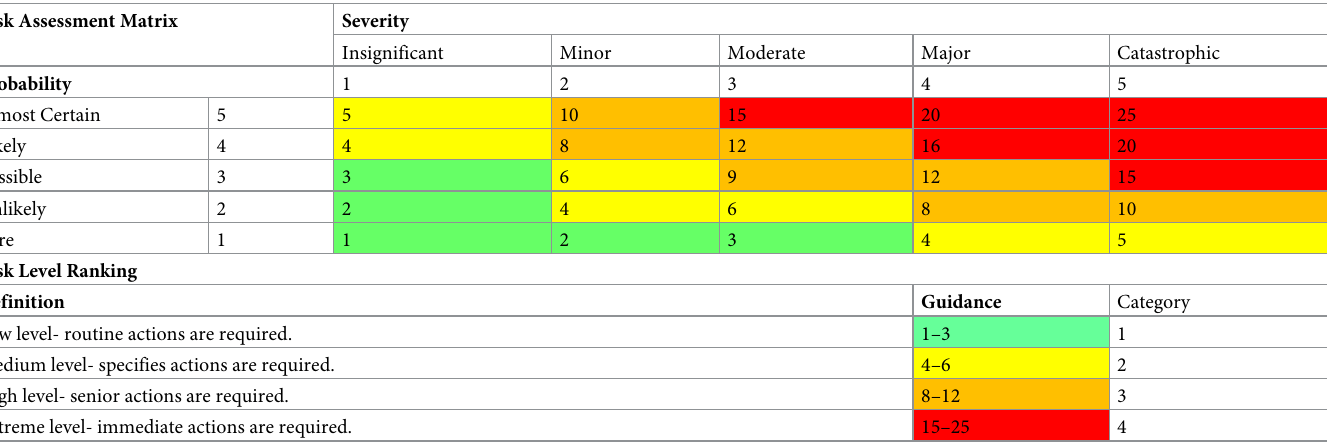
Table 1. Risk assessment matrix